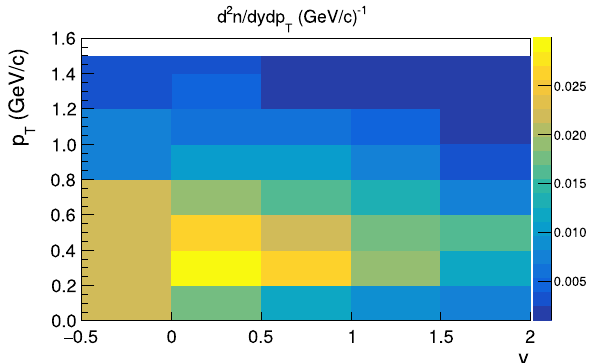
Fig. 9 Double-differential K ∗ ( 892 ) 0 spectra in inelastic p+p interac- tion at 158 GeV / c in bins of ( y , p T ) as obtained from Eq. (10). The numerical values are given in Table 3